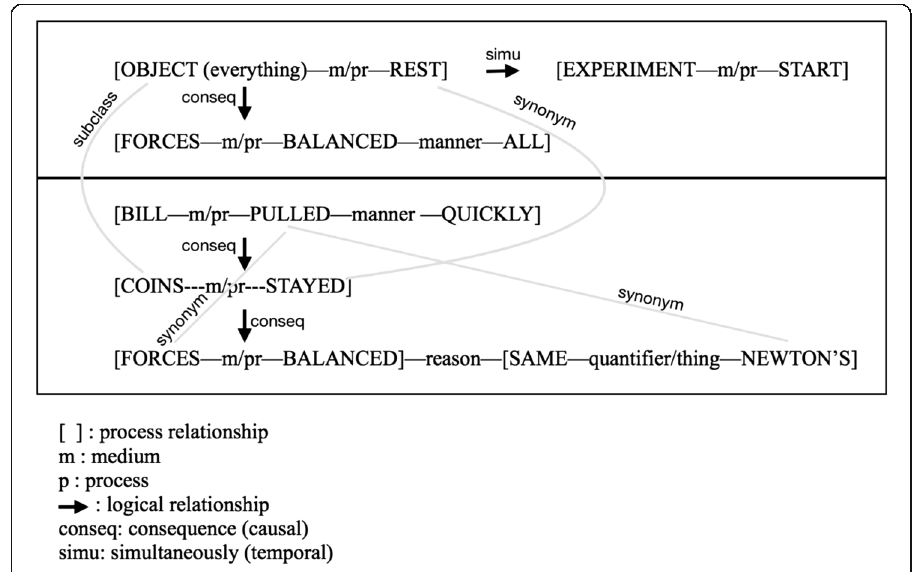
Fig. 4 Student K ’ s Written